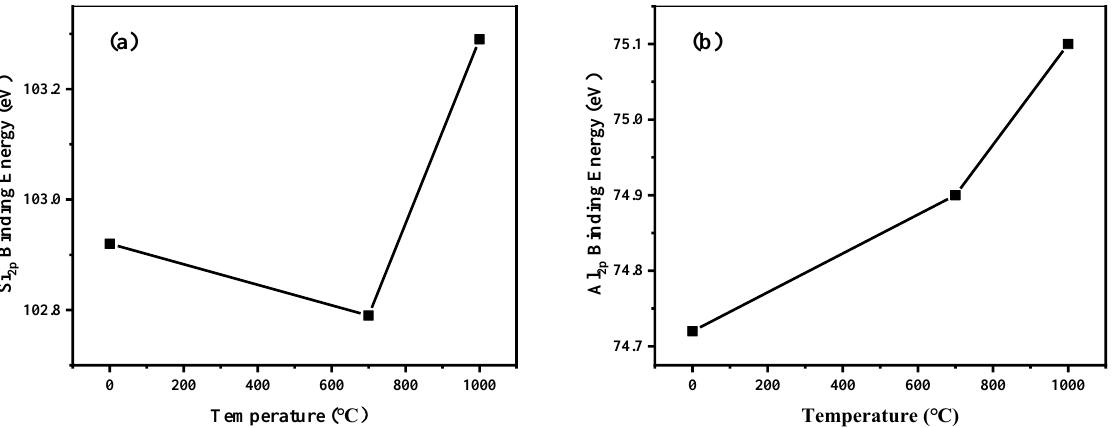
Figure 10. The binding energies of Si 2p and Al 2p for raw and calcined KAS under air atmosphere. ( a ) Si 2p, ( b ) Al 2p.